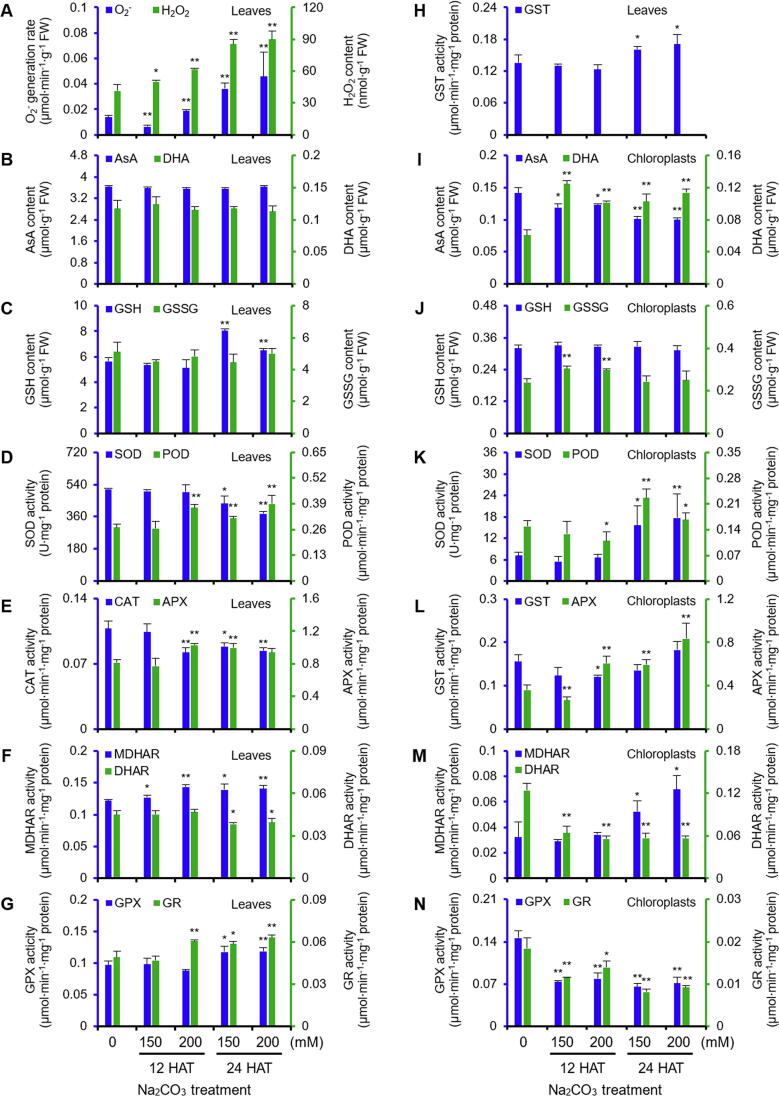
Effects of Na2CO3 treatments on antioxidant systems in leaves and chloroplasts of alkaligrassA. O2− generation rate and H2O2 content in leaves. B. Ascorbate (AsA) and dehydroascorbate (DHA) contents in leaves. C. Glutathione (GSH) and oxidized glutathione (GSSG) contents in leaves. D. Superoxide dismutase (SOD) and peroxidase (POD) activities in leaves. E. Catalase (CAT) and ascorbate peroxidase (APX) activities in leaves. F. Monodehydroascorbate reductase (MDHAR) and dehydroascorbate reductase (DHAR) activities in leaves. G. Glutathione peroxidase (GPX) and glutathione reductase (GR) activities in leaves. H. Glutathione S-transferase (GST) activity in leaves. I. AsA and DHA contents in chloroplasts. J. GSH and GSSG contents in chloroplasts. K. SOD and POD activities in chloroplasts. L. GST and APX activities in chloroplasts. M. MDHAR and DHAR activities in chloroplasts. N. GPX and GR activities in chloroplasts. The values were determined after plants were treated with 0, 150 or 200 mM Na2CO3 for 12 or 24 h (12 HAT150, 12 HAT200, 24 HAT150, and 24 HAT200), and were presented as means ± S.D. (n ≥ 3). The asterisks indicate significant differences (Student's t test, *, P < 0.05; **, P < 0.01).